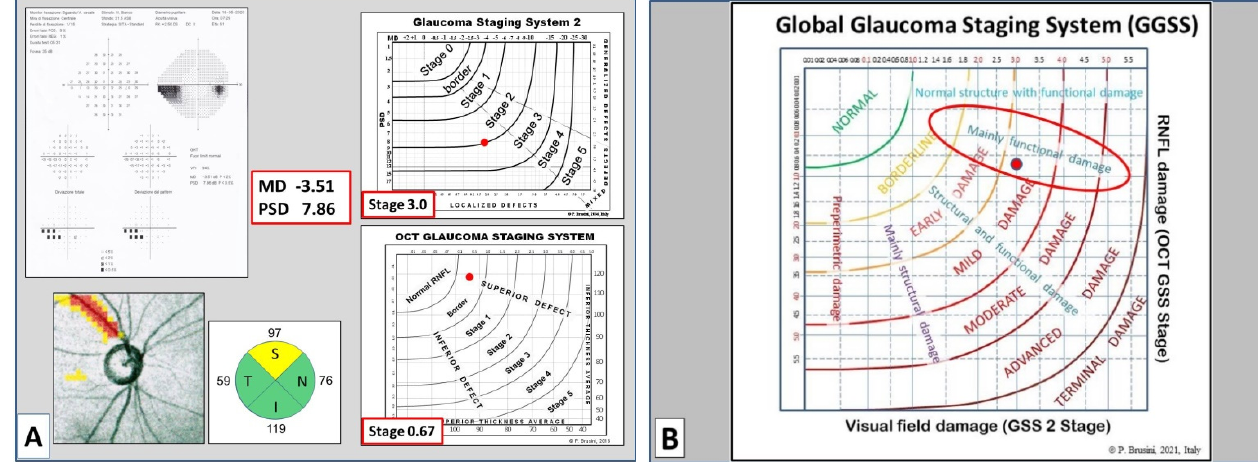
Figure 5. ( A ) 55 year old patient with primary OAG with a deep defect in the inferior nasal quadrant (GSS 2 Stage 3.0); OCT shows a subtle superior nerve fiber defect (OCT GSS Stage 0.67). This was considered as Stage 2, according to the clinical classification; ( B ) this case is classified as having a mild damage with a predominant functional defect.